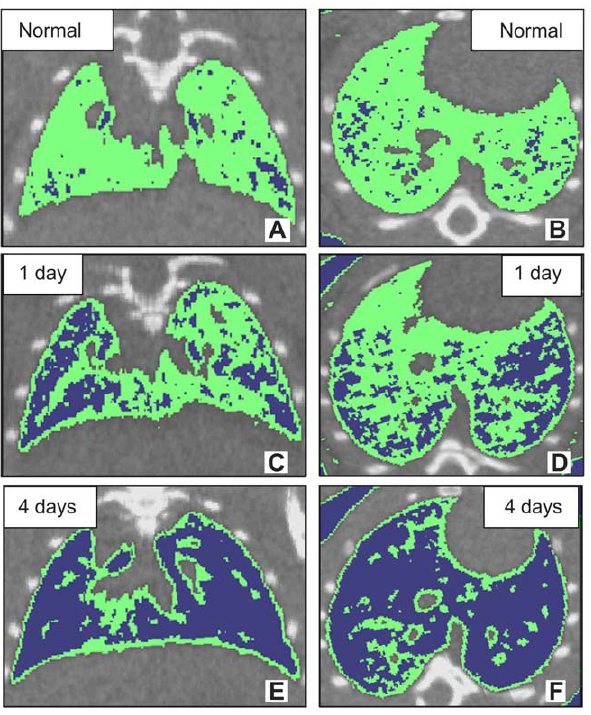
Figure 1. Micro-CT images. Typical images of micro-CT in normal (A and B) and radiation-induced lung injury mice (C, D, E and F). Top panel: micro-CT images of normal mouse lung (A and B). Middle panel: micro- CT images of radiation-induced mouse lung injury at 1 day after x-ray exposure (C and D). Bottom panel: micro-CT images of radiation- induced mouse lung injury at 4 days after X-ray exposure (E and F). (A, C and E) transaxial slice orientation. (B, D and F) horizontal slice orientation. Areas of density between 2 200 to 2 500 HU on three- dimensional micro-CT slices were shown in green. Areas of density below 2 500 HU on three-dimensional micro-CT slices are shown in blue. doi:10.1371/journal.pone.0045960.g001 x-ray exposure. In comparison, normal mice had a mean lung air space of 26.5 6 3.1 m m (Figure 3D).